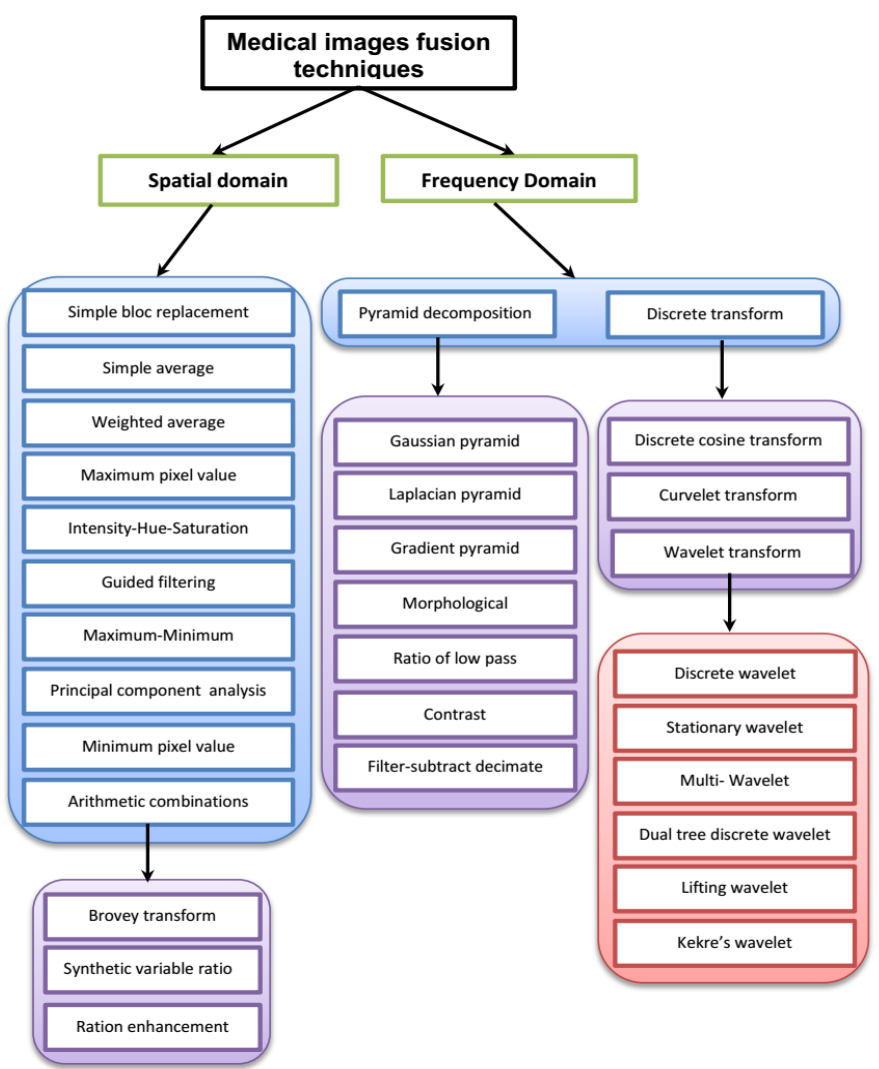
Figure 4. Multimodal fusion techniques in spatial and frequency domains for brain images. In this work, image fusion methods have been classified into two categories (green color) according to the domain from which the image is transferred, namely spatial and frequency domains.